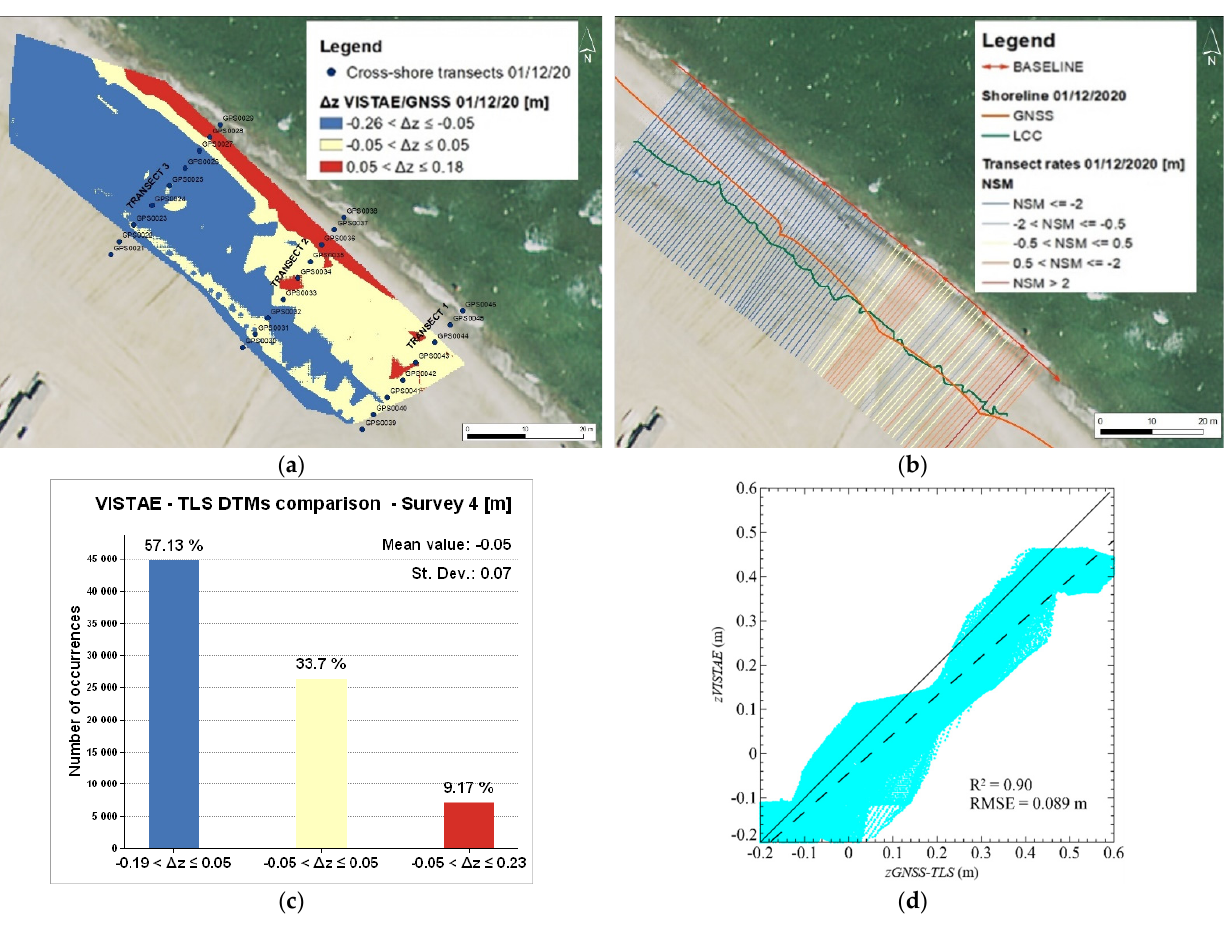
Figure 8. ( a ) Height difference between the low-cost camera (VISTAE) and GNSS elevation models obtained from survey 4 (1 December 2020); mean value and standard deviation are ( − 0.02 ± 0.03) m. ( b ) Comparison between the shorelines (zero contours) extracted by GNSS survey (orange line) and by low-cost camera (VISTAE), green line. The transect colors represent the Net Shoreline Movement (NSM) calculated with the DSAS tool. ( c ) Histogram reporting classes of Δ z distribution as percentages. ( d ) Scatter plot with linear regression parameters between VISTAE and GNSS elevations (in m); solid line is the bisector (slope 1:1), while dashed line is a linear fitting of the data; R 2 and RMSE are 0.90 and 0.089 m.